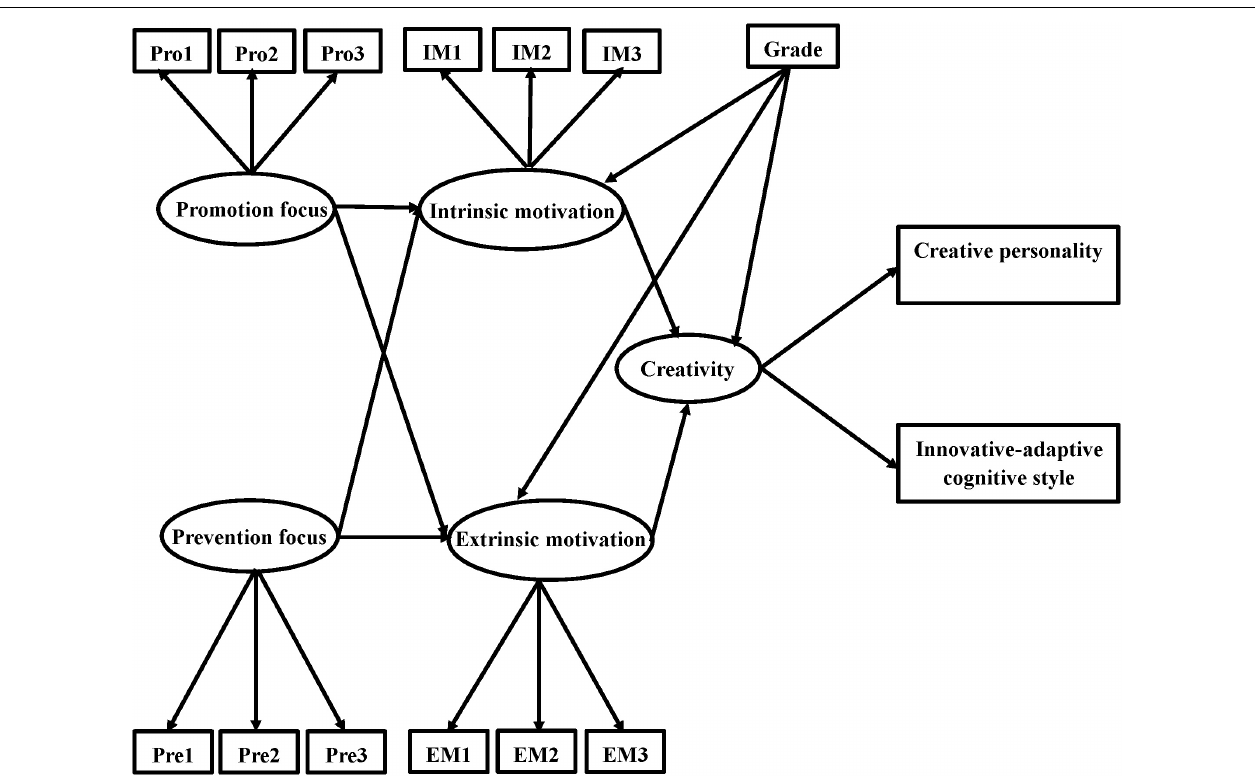
FIGURE 1 | The hypothesized model of regulatory focus, motivation, and